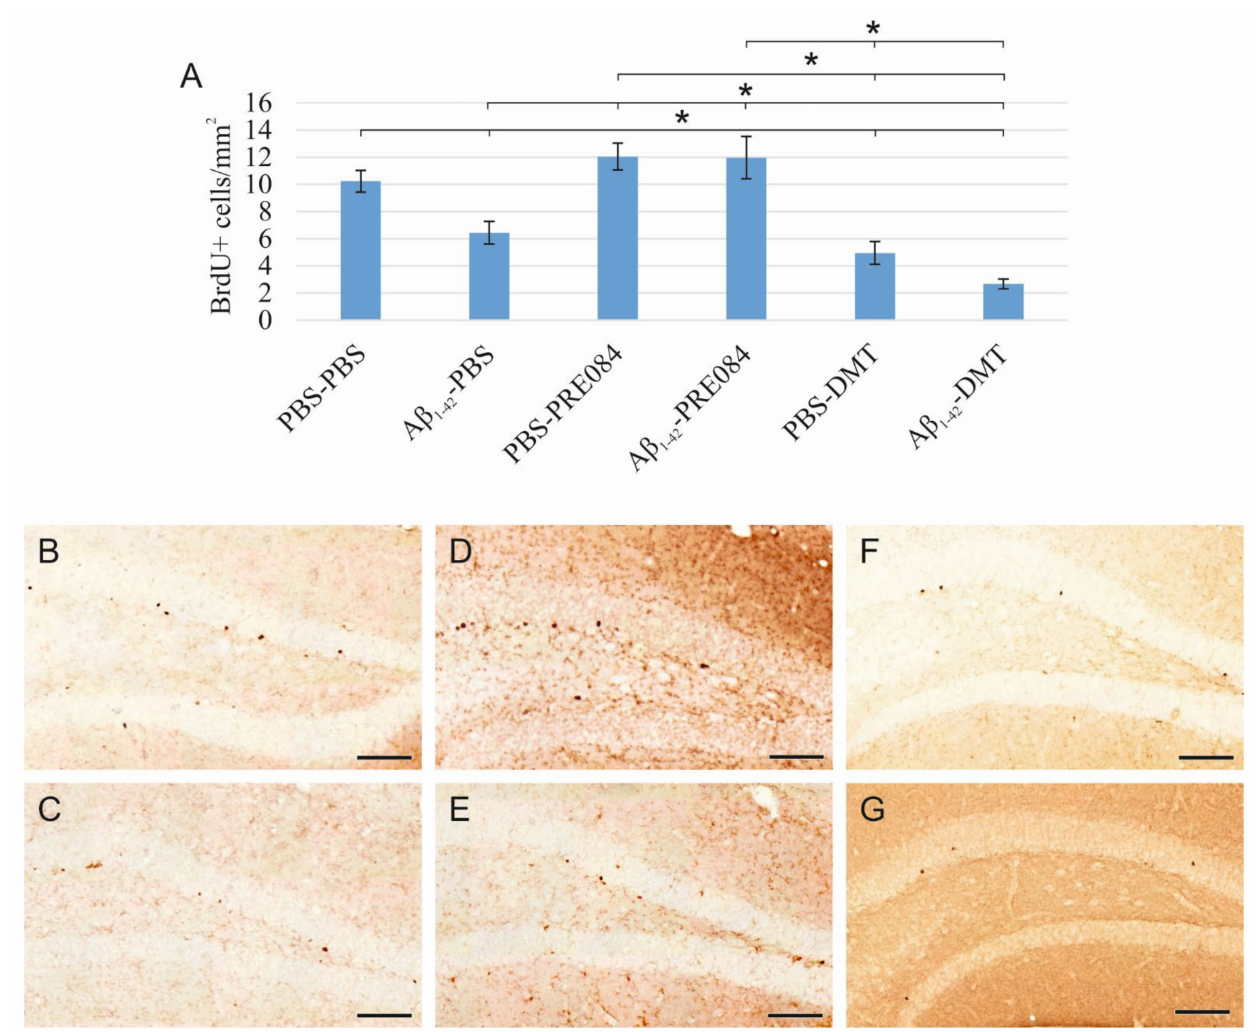
Figure 1. ( A ) Results for 5-Bromo-2 (cid:48) -Deoxyuridine (BrdU) immunolabeling. We observed significant differences in the quantity of stem cells between the six groups (ANOVA: p ≤ 0.0001). Significantly fewer BrdU+ cells were detected in the A β 1–42 -PBS, PBS-DMT, and in the A β 1–42 -DMT treated animals compared to the PBS-PBS group (PBS-PBS vs. A β 1–42 -PBS p = 0.001, vs. PBS-DMT p =